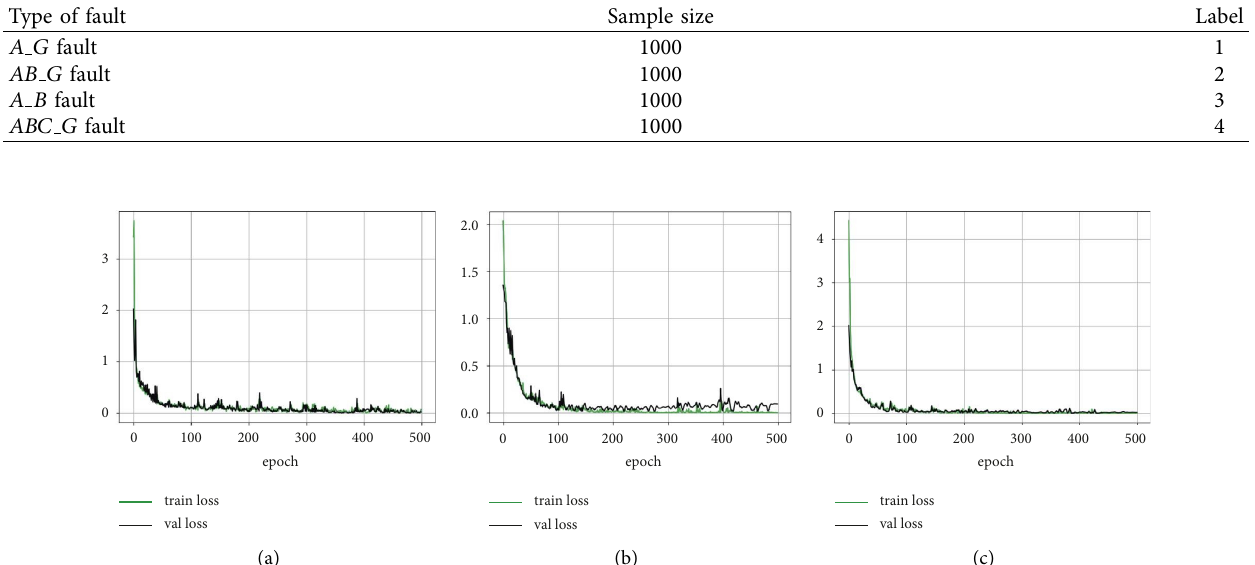
Figure 7: Loss function curves of various network models. (a) 1DCNN network. (b) 1D-LSTM network. (c) 1DCNN-BiLSTM network.